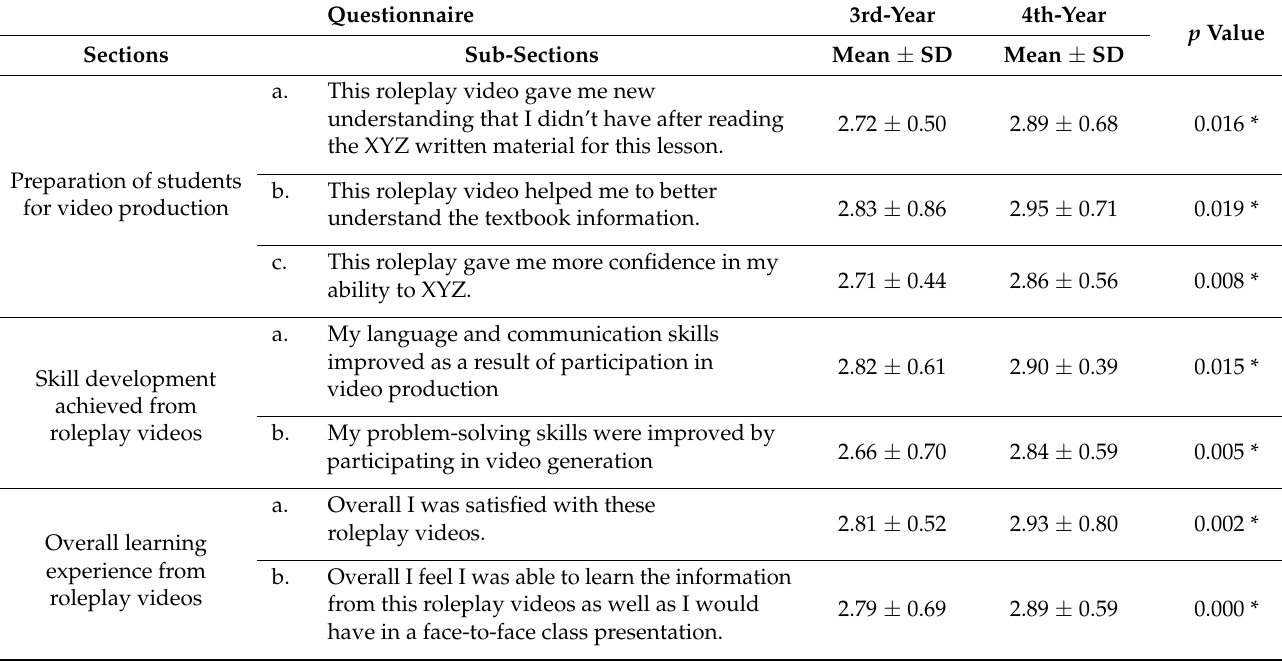
Table 3. Comparison of feedback responses for roleplay videos in relation to third-year and fourth- year levels of BDS